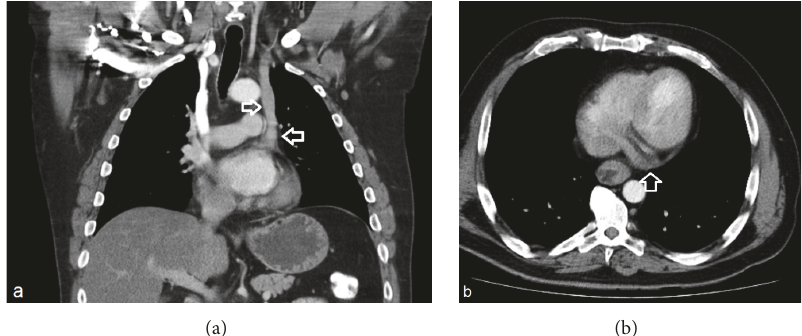
Figure 3: CT of the thorax, including coronal and axial cuts. In picture (a), white arrows show the passage of the PLSSVC while in picture (b) the ending in the coronary sinus is